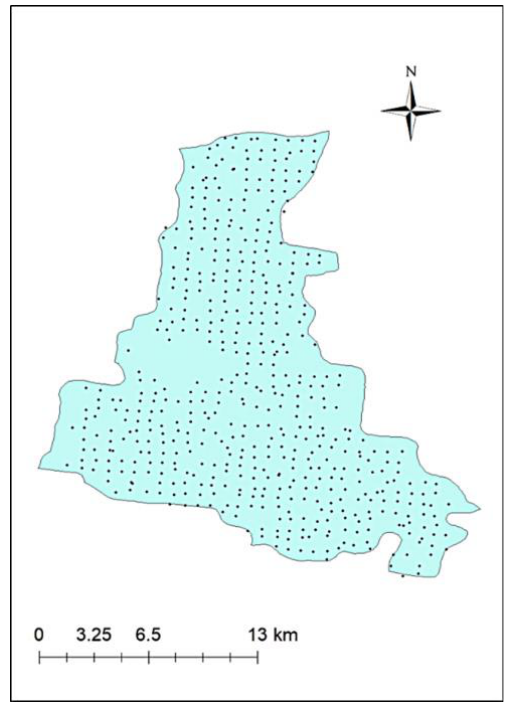
Figure 1. Distribution of sampling points in Quzhou County.